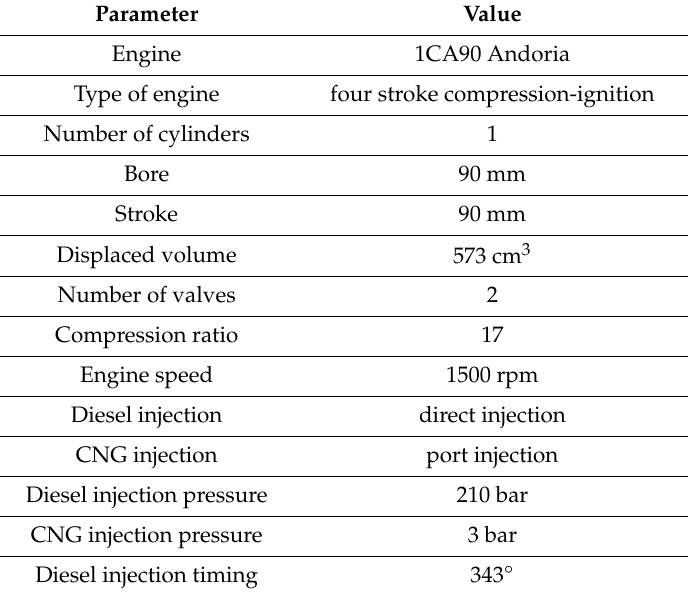
Figure 1. Schematic diagram of the experimental setup. Table 1. Main engine parameters.